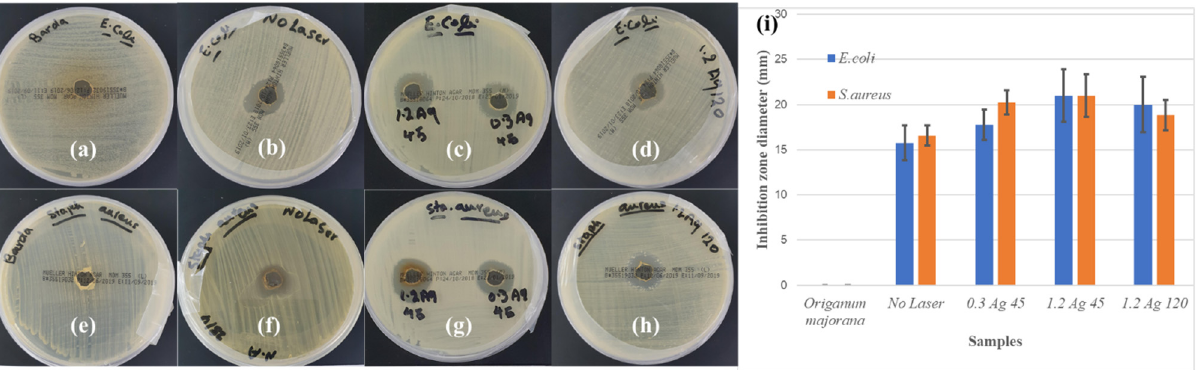
Figure 8. Inhibition zone photos of Ag NPs against microorganisms E. coli (top row) and S. aureus (bottom row) for ( a , e ) Origanum majorana extract solution, ( b , f ) chemical reduction only, ( c , d , g , h ) chemical reduction with simultaneous PLFL for different concentrations of Origanum majorana extract and different irradiation times, and ( i ) antimicrobial activity level of the produced Ag NPs.